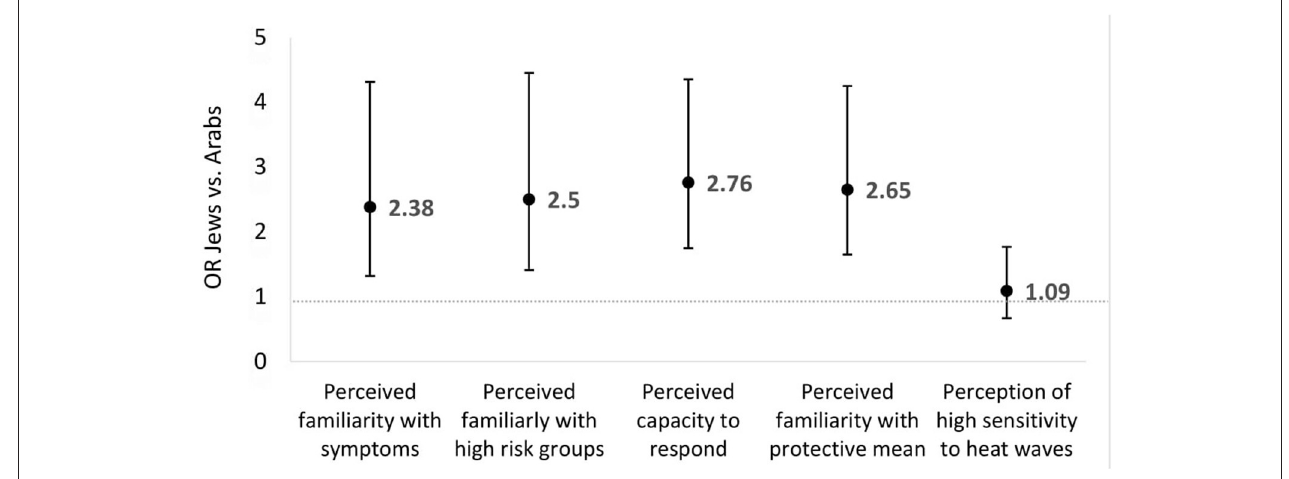
FIGURE 2 | Regression models of perceived familiarity of heat waves among Jewish vs. Arab respondents.